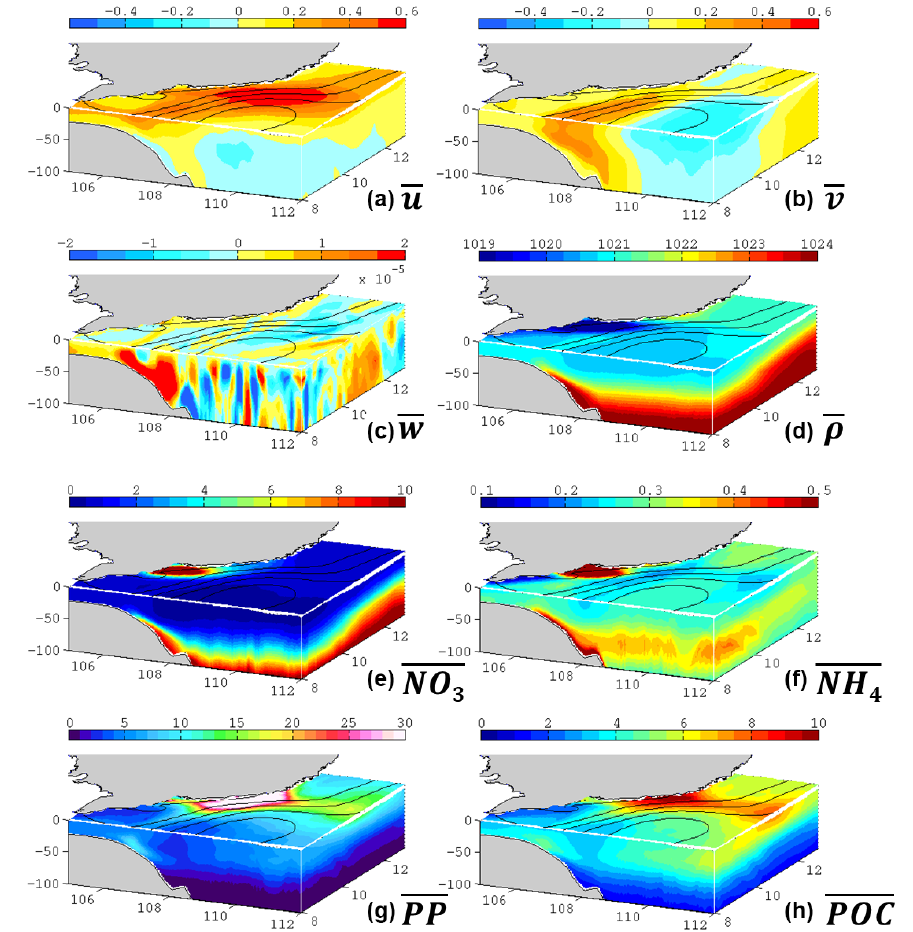
Figure 9. Three-dimensional distribution (standard run) of the summer mean (a) zonal velocity in ms − 1 , (b) meridional velocity in ms − 1 , (c) vertical velocity in ms − 1 , (d) potential density in kgm − 3 , (e) nitrate in mmolm − 3 , (f) ammonium in mmolm − 3 , (g) primary production in mgCm − 3 day − 1 , and (h) particulate organic carbon in mmolCm − 3 . Overlapped contours are the mean sea level (every